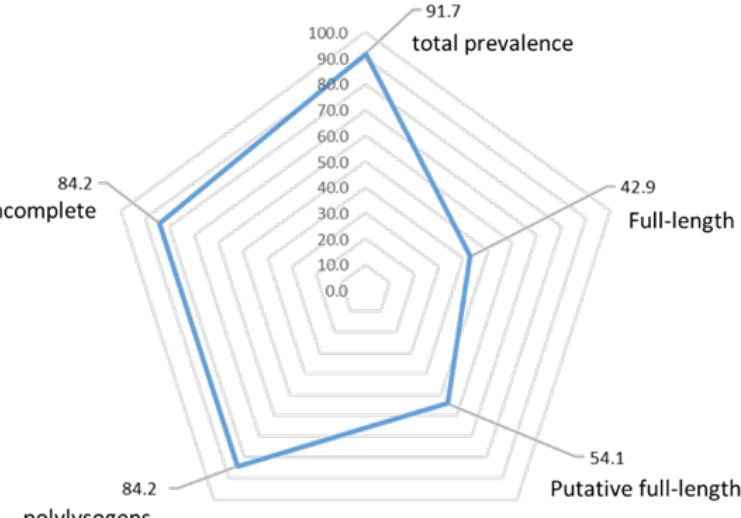
Figure 3. Prevalence of prophages in S. suis genomes. Predicted regions were categorised into full- length (42.9%), putative full-length (54.1%), and incomplete prophages (84.2%). Of the 133 genomes, 84.2% are polylysogens—strains harbouring more than one phage region.